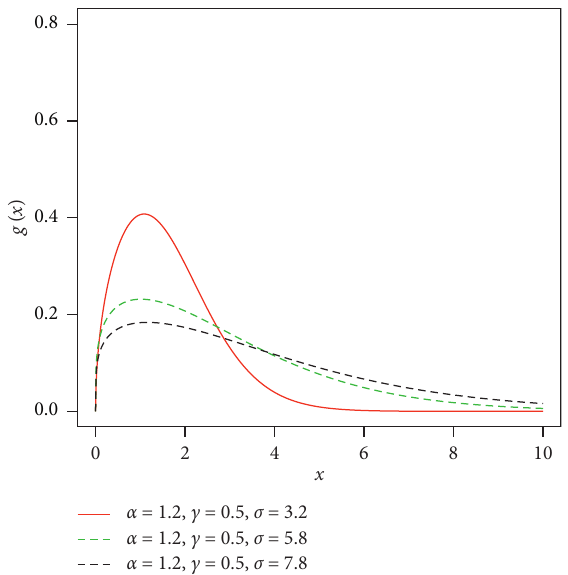
Figure 1: Pdf plots of the ETX-Weibull model for α � 1 . 2, c � 0 . 5, and different values of σ